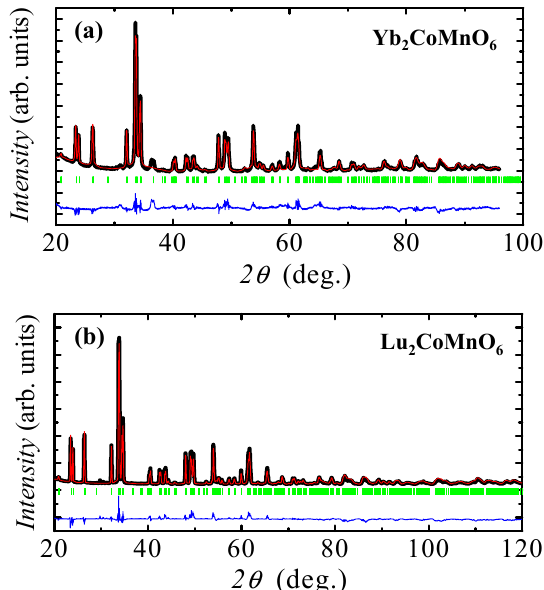
Figure 2. Observed (open circles) and calculated (solid line) powder XRD patterns for YCMO ( a ) and LCMO ( b ). The single phase of the monoclinic perovskite structure (space group P 2 1 /n ) was identified.